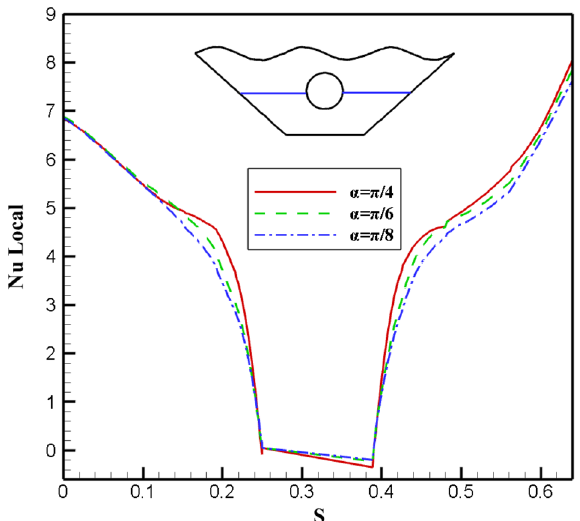
Figure 21. Local Nusselt number plot for differentangle of magnetic field (α).